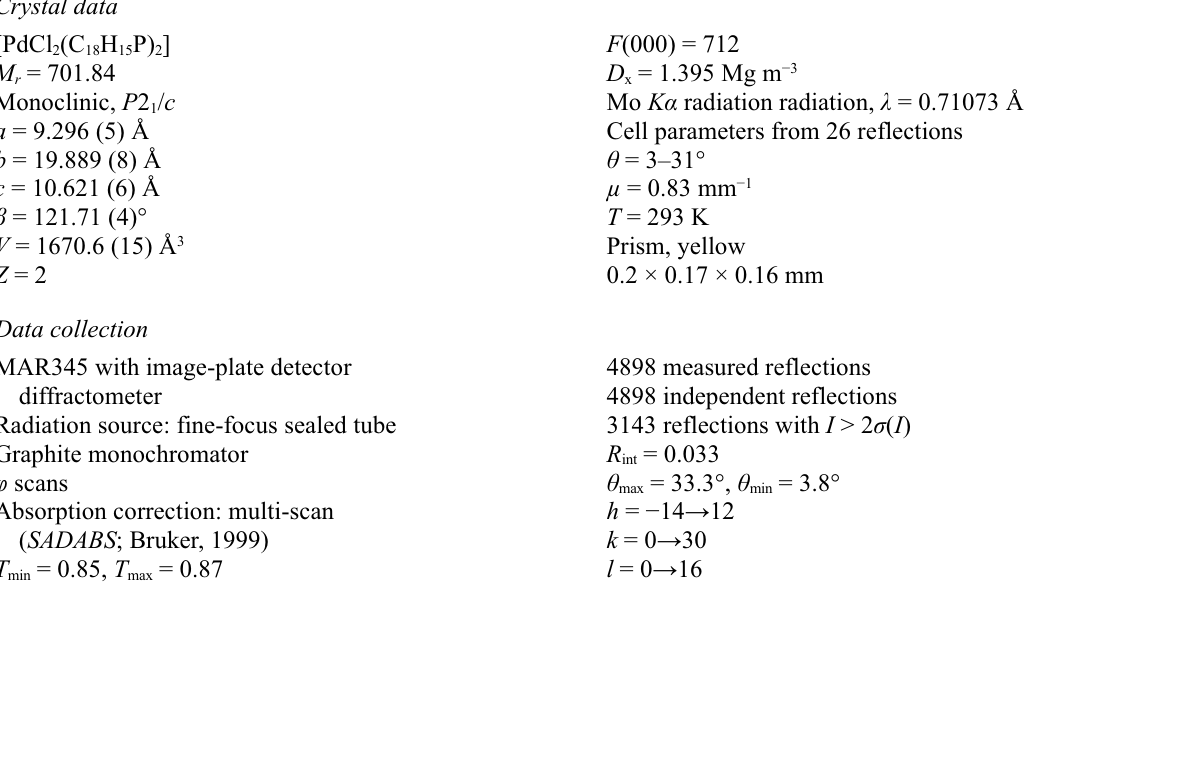
Figure 1 trans -Dichlorobis(triphenylphosphine)palladium(II) trans -Dichloridobis(triphenylphosphine)palladium(II) Crystal